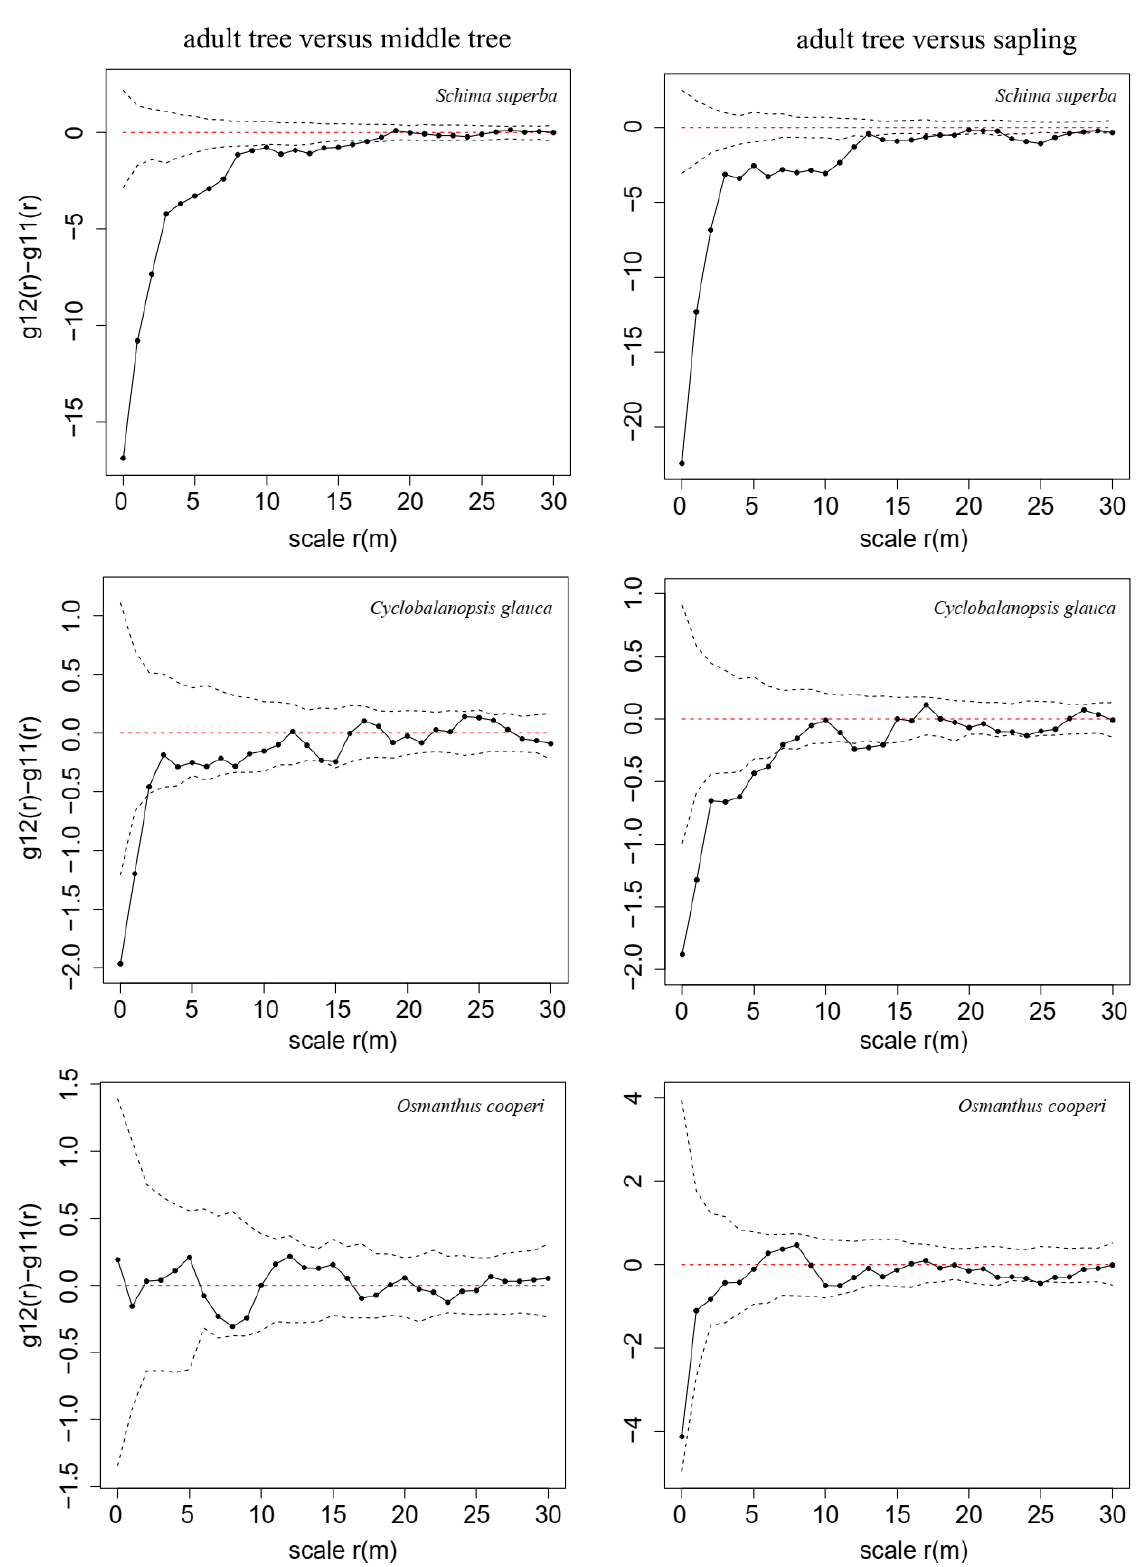
Figure 5. Juvenile–adult ( left ) and sapling–adult ( right ) comparative analyses of Schima superba , Cyclobalanopsis glauca , and Osmanthus cooperi with random labelling case–control design.